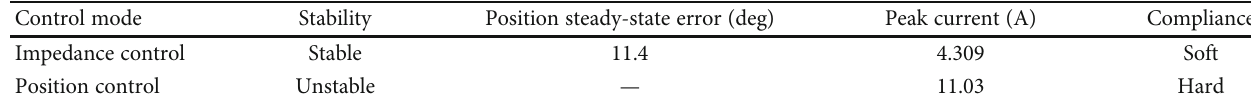
Figure 14: The current and position variation of the knee motor under pure position control. Table 2: Comparison between pure position control and impedance